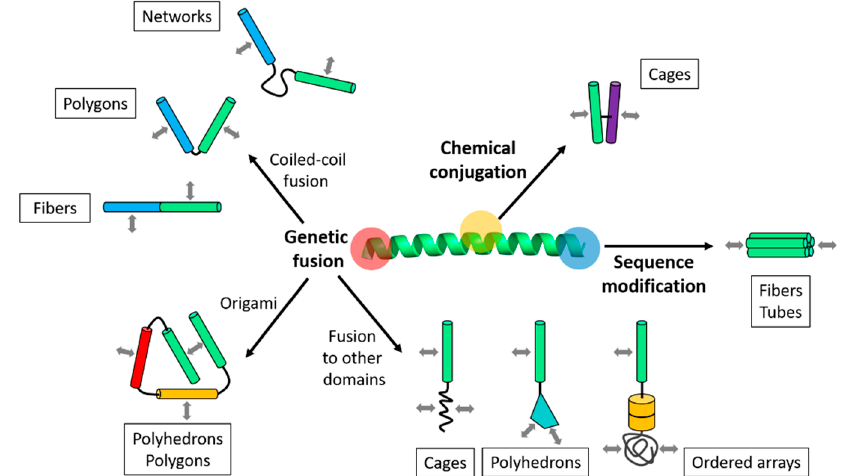
Figure 2. Modular design principles of coiled-coil-based protein building blocks. Building blocks are designed through variations of a coiled-coil peptide, which include genetic fusion, chemical conjugation, and sequence modification. In the genetic fusion approach, coiled-coils are linked with or without orientational controls. They are also combined into fusion proteins for origami or fused to other domains. Association contacts on each building block are indicated by arrows (gray). The types of resulting supramolecular nanostructures are indicated in the boxes, and more details are summarized in Table 1.